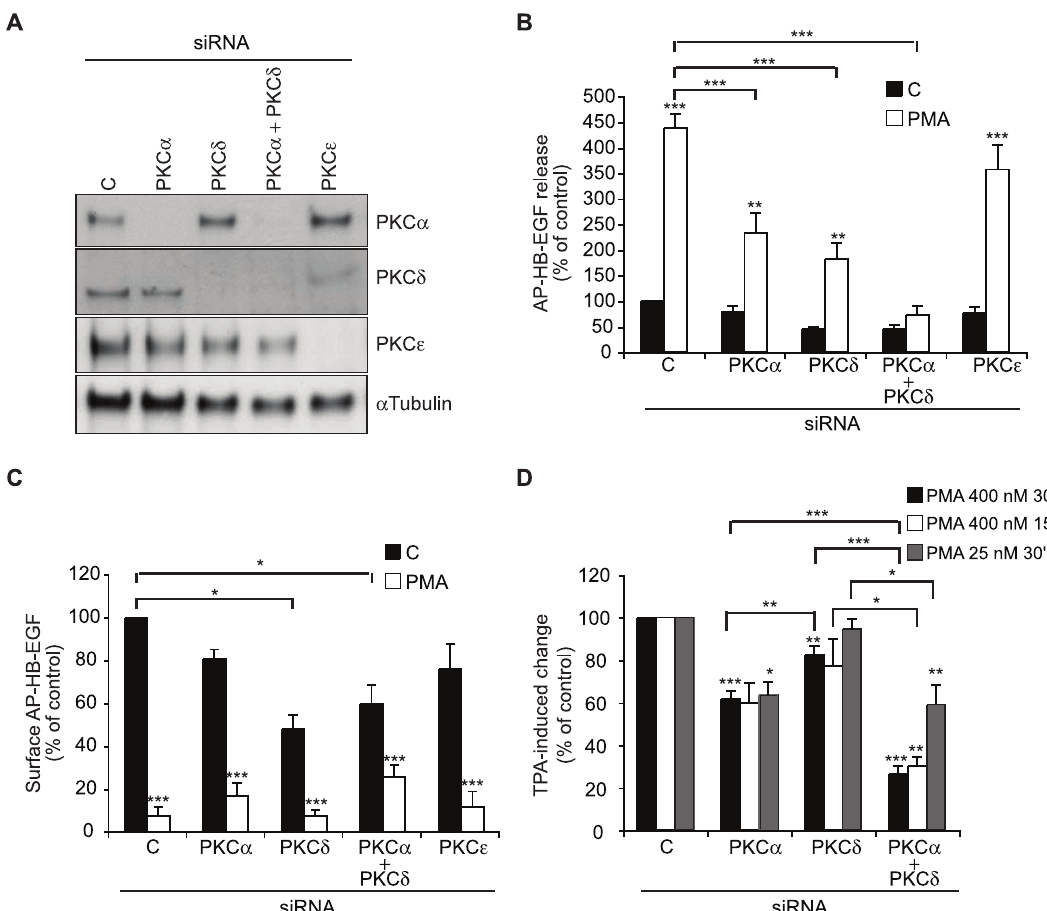
Figure 4. PMA-induced HB-EGF shedding involves cooperative functions of PKC a and PKC d . A ) Western blot analysis of PKC a , PKC d , and PKC e in total cell extracts from AP-HB-EGF expressing HT1080 cells reverse transfected with control (C) siRNAs or siRNAs against the indicated PKC isoforms. a -Tubulin is used as an internal loading control. B ) AP-HB-EGF release measured as alkaline phosphatase activity (OD 405 nm) in conditioned media and C ) surface AP-HB-EGF measured as cell surface fluorescence intensity per cell (FLU/cell) in DMSO control-treated (C; black bars) and 30 min PMA-treated (PMA; white bars) in AP-HB-EGF expressing HT1080 cells 72 h after reverse transfection with control (C) siRNAs or siRNAs against the indicated PKC isoforms. D ) Fold PMA-induced change in alkaline phosphatase activity (% of control) in conditioned media from AP-HB-EGF expressing HT1080 cells treated for 15 or 30 min with either low (25 nM) or high (400 nM) concentrations of PMA, 72 h after reverse transfection with the indicated siRNAs. All graphs show average values 6 standard error of the mean of at least three independent experiments each done in triplicate. *p , 0.05; **p , 0.01, ***p , 0.001 after one-way analysis of variance with Bonferroni’s post tests for multiple comparisons. Unless otherwise indicated, the comparison is relative to the respective